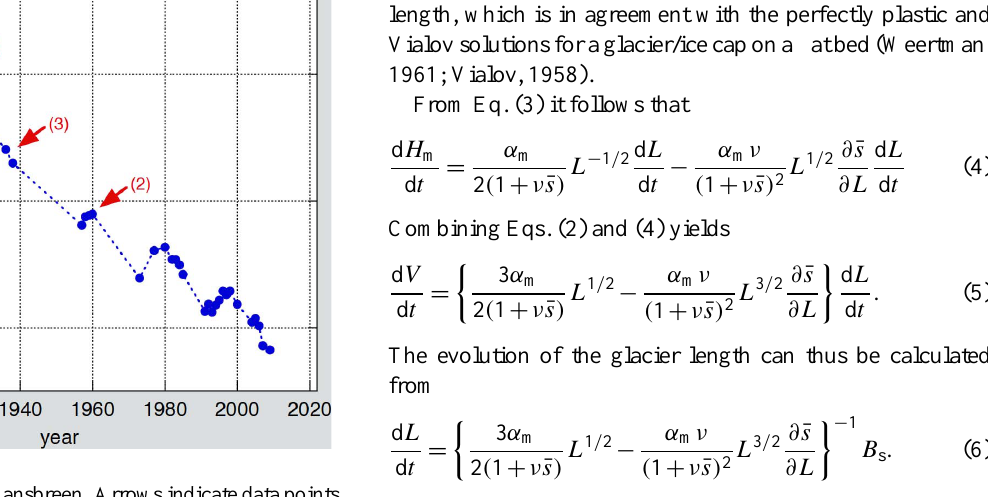
Fig. 3. The length record of Hansbreen. Arrows indicate data points that have been given a larger weight in the calibration procedure (weights given in brackets), as described in Sect.